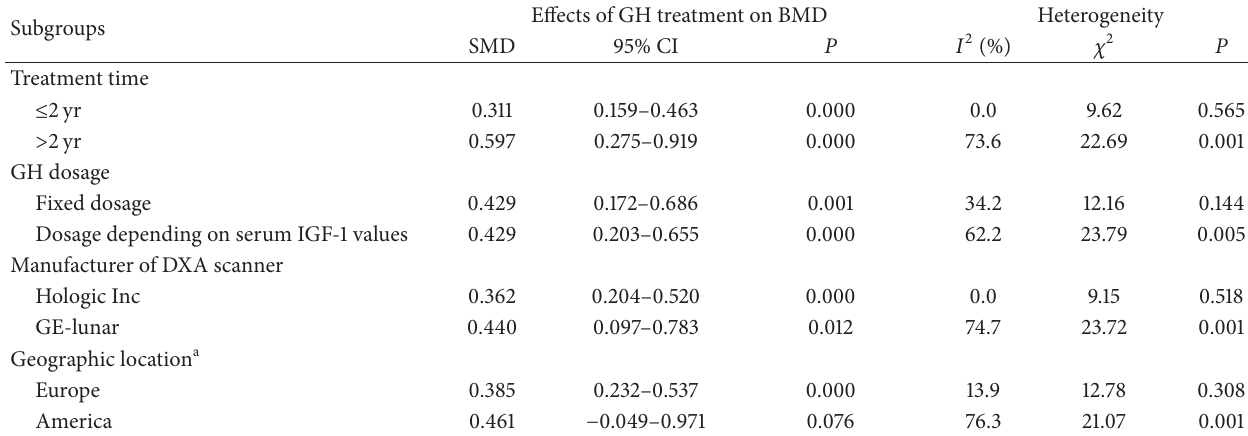
Table 3: Subgroup analyses results of the association between GH treatment and BMD of spine